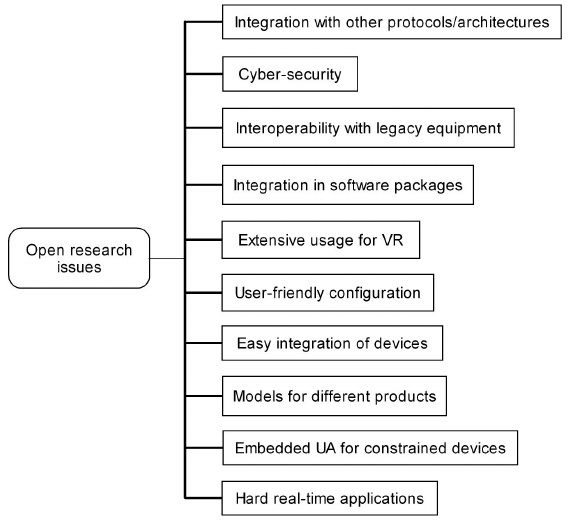
Figure 15. Scheme of the identified open research issues.